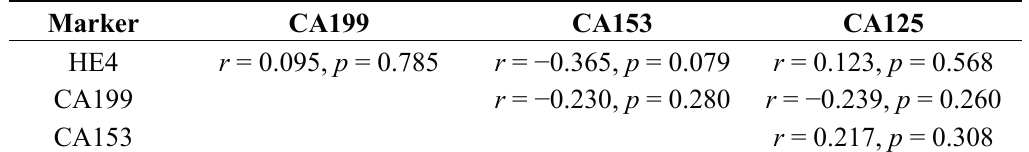
Table 4. Correlations among serum levels of HE4, CA19-9, CA15-3 and CA125 in pancreatic adenocarcinoma patients’ serum. There was no correlation between each two serum markers out of the four markers tested ( p > 0.05).